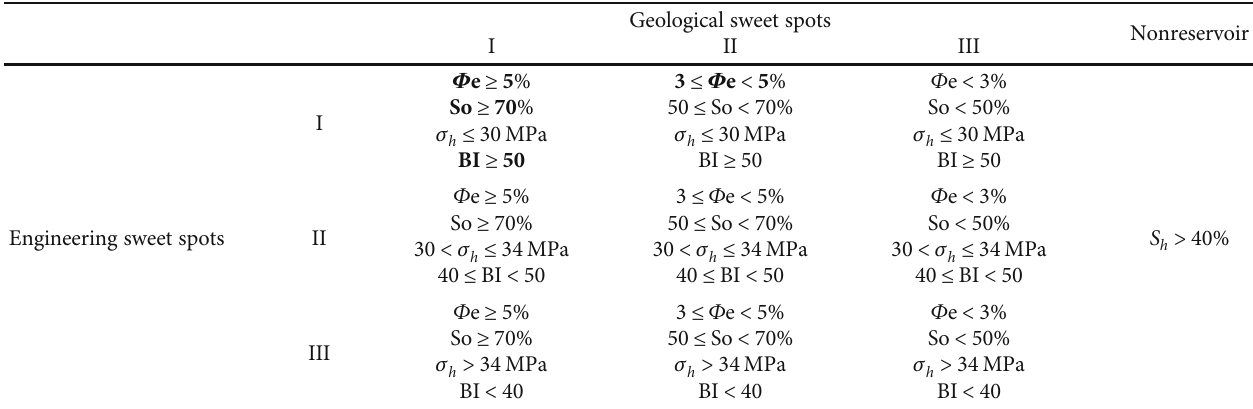
Figure 15: Comparison of single-stage cluster and e ff ective clusters in Marcellus, Haynesville, Eagleford, Fayetteville, Barnett, and Woodford shales [27]. Table 4: Integrated sweet spot identi fi cation